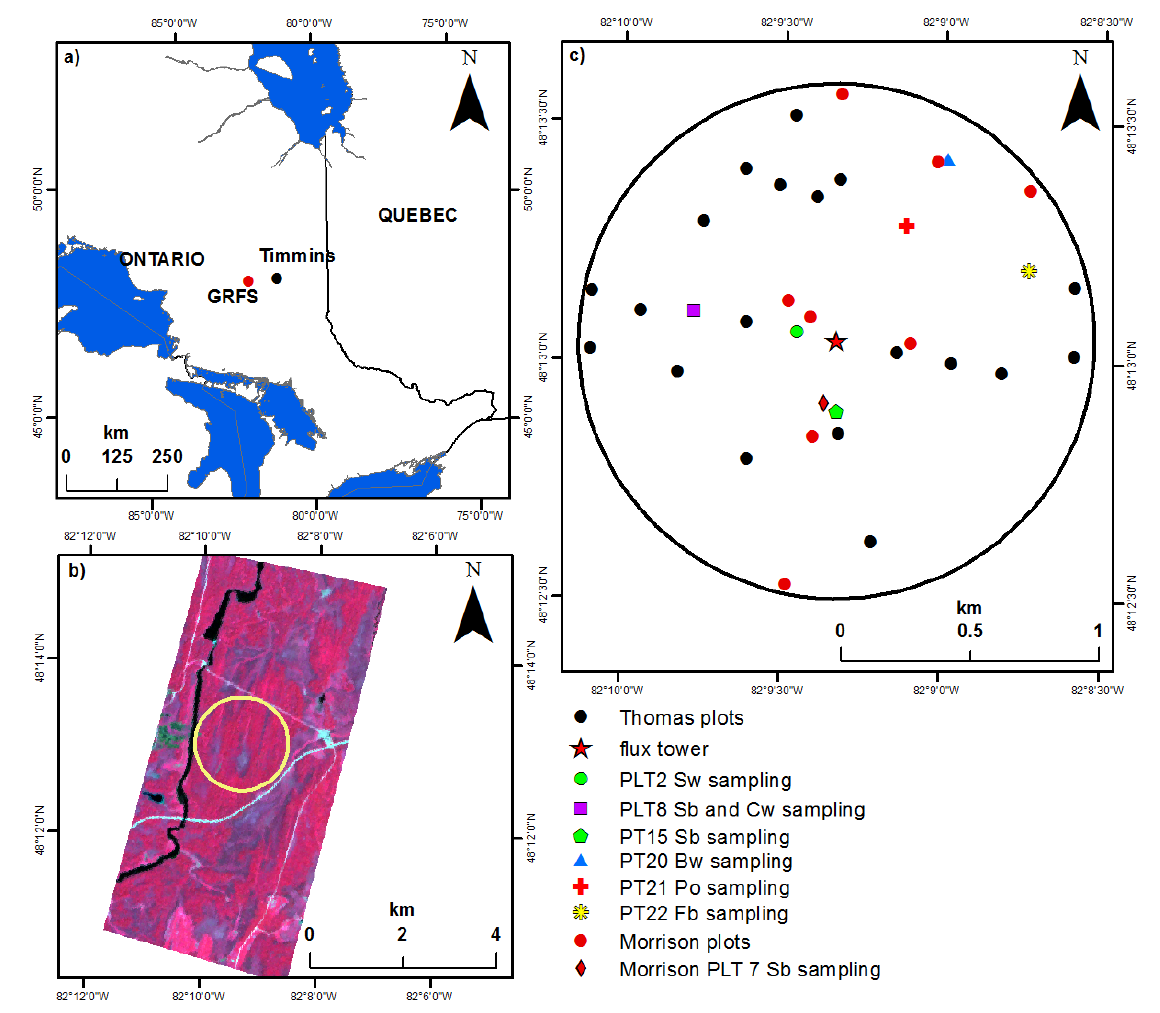
Figure 1. ( a ) Location of the Groundhog River Flux Station (GRFS). ( b ) Flux tower footprint at the mixedwood forest at the GRFS. ( c ) Plot layout and sample plot locations at the mixedwood forest site. Sw = white spruce ( Picea glauca ); Cw = northern white cedar ( Thuja occidentalis ); Sb = black spruce ( Picea mariana ); Bw = white birch ( Betula papyrifera ); Po = trembling aspen ( Populus tremuloides ); Fb = balsam fir ( Abies balsamea